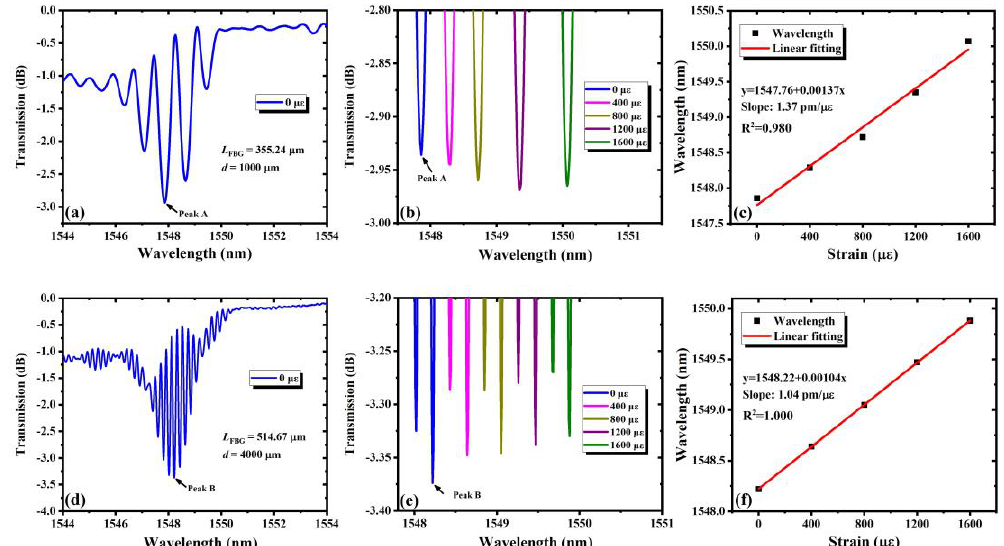
Figure 10. Results of the measured strain response characteristics: ( a – c ) FPC-I; ( d – f ) FPC-IV. ( a , d ) show the transmission spectra; ( b , e ) show the resonance peaks shift with strain; ( c , f ) show the linear fitting of the peak wavelength shift.